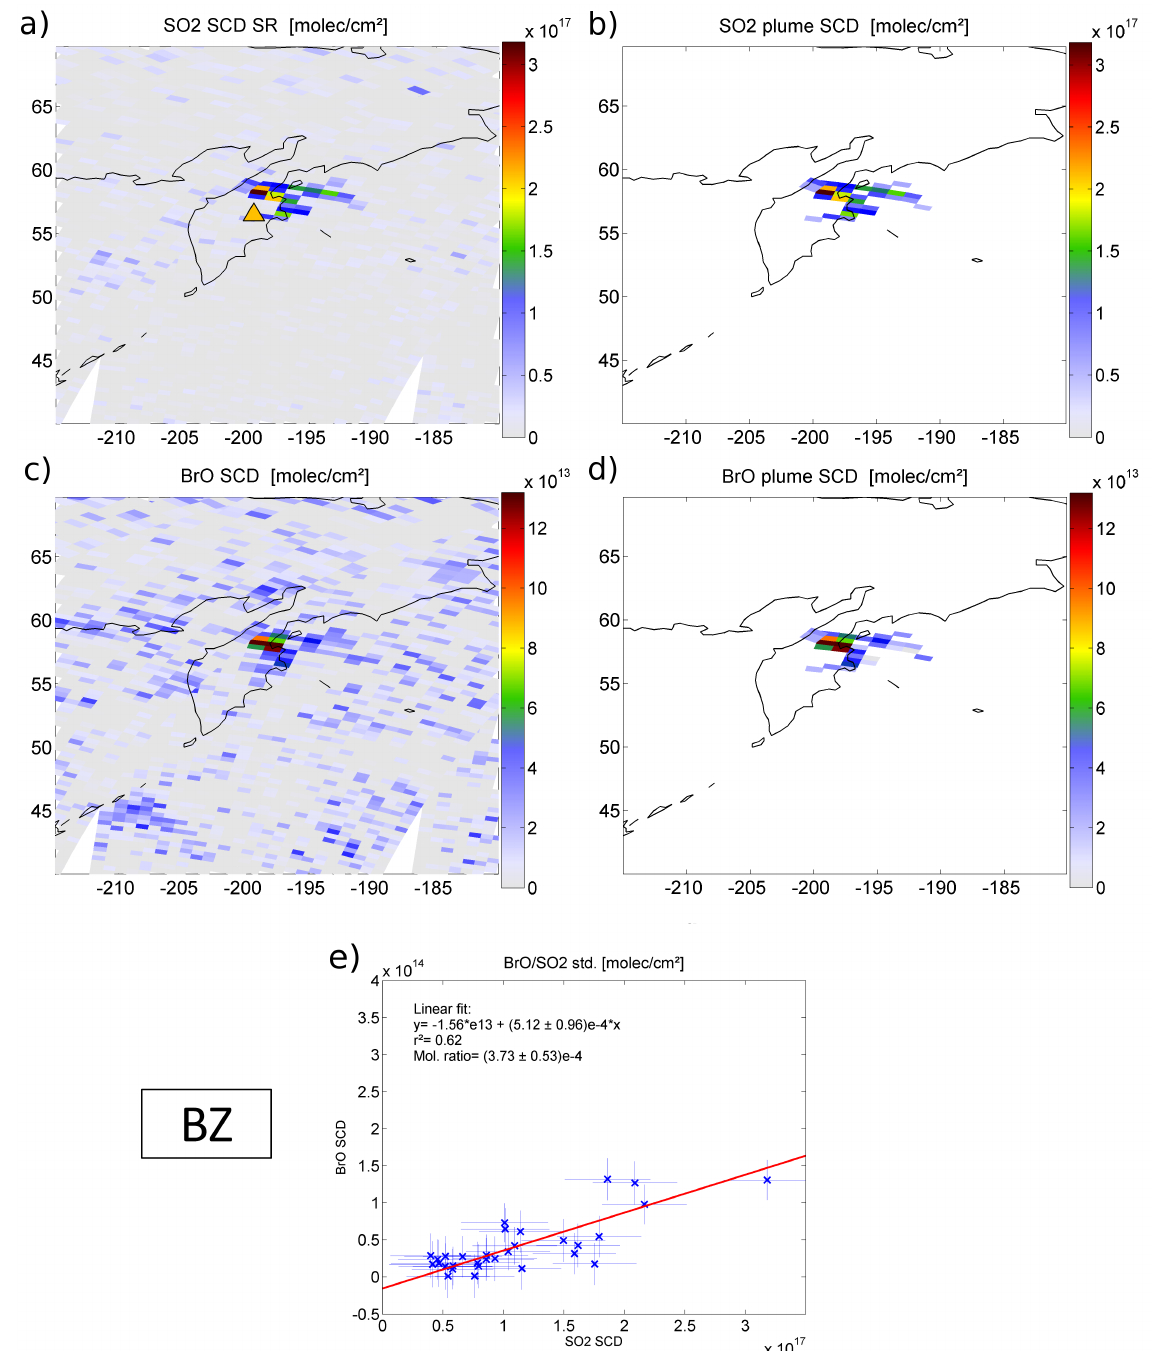
Fig. 8. SO 2 and BrO SCDs during an eruptive phase of Bezymianny volcano (Kamchatka Peninsula) on 11/12 May 2007. Next to the SO 2 plume (a) , volcanic BrO was present, as the BrO SCDs are clearly enhanced in the vicinity of the SO 2 plume (c) . The satellite pixel with SO 2 SCDs > 3 σ of the reference area are shown in (b) and (d) for both species. The correlation plot for the identified plume pixels (e) shows a linear relationship between the two species ( r 2 =0.62) and a fitted mean BrO/SO 2 ratio of (5.12 ± 0.96) × 10 − 4 .